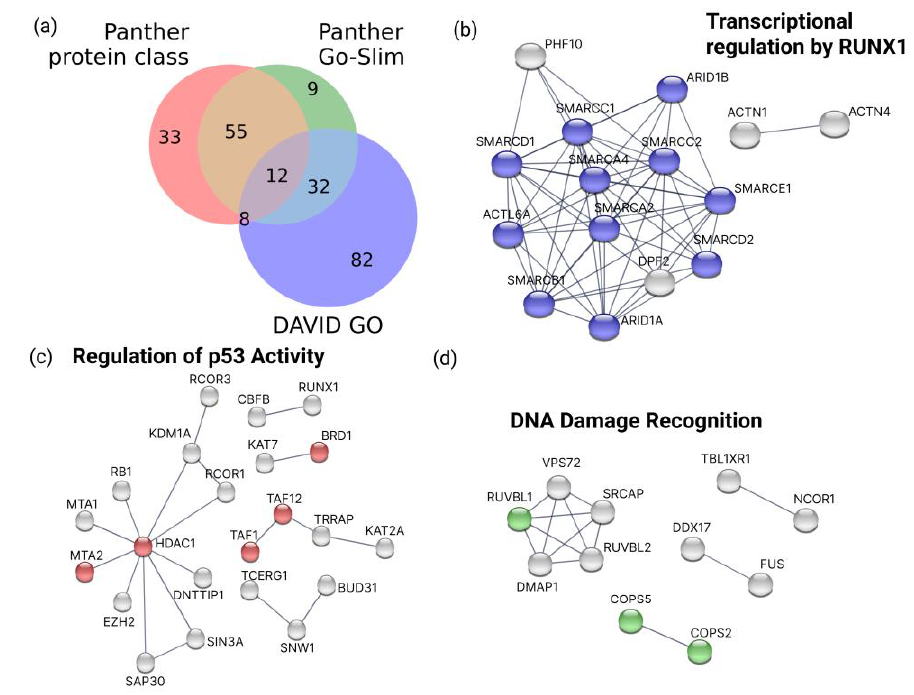
Figure 3. Results of bioinformatic analysis of proteins identified in the HL-60 nuclear fraction by MS/MS mass spectrometry. ( a ) Venn diagram shows proteins recognized as gene-specific transcriptional regulators (PC00264) according to the Panther protein class (Panther), as proteins with transcription regulator activity (GO:0140110) according to the Panther Go-Slim Molecular Function (Panther Go-Slim), and as proteins with transcription factor activity and protein binding (GO:0000988) according to the GeneOntology (GO) Molecular Function (DAVID). Results of analysis by STRING database v.11.0 (the highest confidence score (0.9), experiments and fusion genes as active interaction sources; k-means clustering into three clusters) are also shown. ( b ) Cluster 1 (input of 86 TFs) was enriched with interactions (PPI enrichment p-value: < 10 -16 ), and with proteins involved in transcriptional regulation by RUNX1 (blue, according to the Reactome pathway). ( c ) Cluster 2 (input of 72 TFs) was enriched with interactions (PPI enrichment p -value: 3.11 × 10 -13 ), and with proteins involved in the regulation of TP53(p53) activity (red, according to the Reactome pathway). ( d ) Cluster 3 (input of 73 TFs) was enriched with interactions (PPI enrichment p-value: 9.76 × 10 -14 ), and with proteins involved in DNA damage recognition in GG-NER (green, according to the Reactome